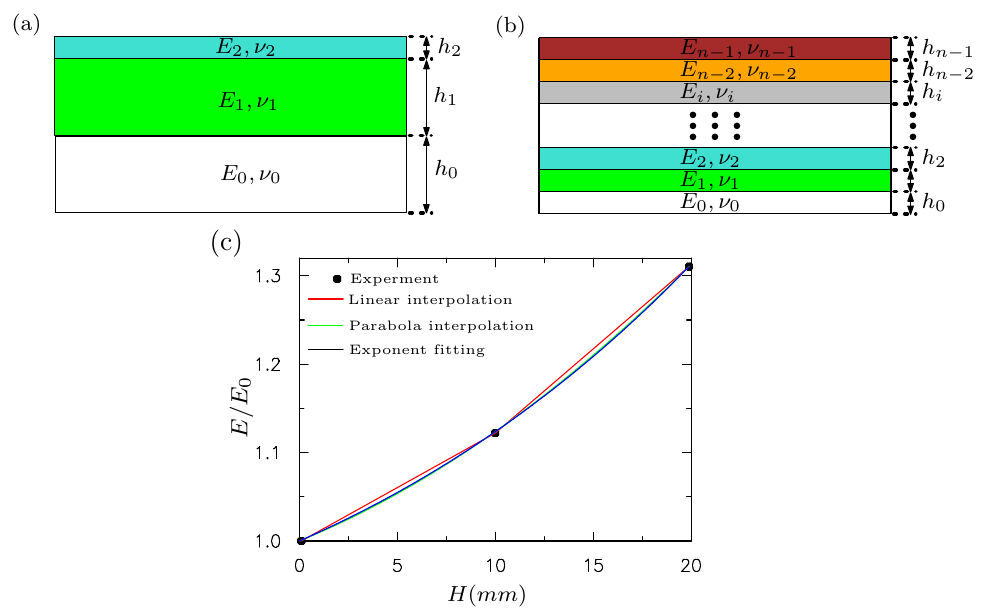
Figure 7. ( a ) schematic for the three-layer finite element model. The height for each layer is h 1 , h 2 , and h 3 with modulus E 0 , E 1 and E 2 , respectively; ( b ) schematic for a multi-layer finite element model with n = 200 layers. The height of the i th layer is h i with modulus E i . The height of each layer ( h i ) is equally distributed in the simulations; ( c ) the normalized modulus vs. height for the multilayer model based on linear interpolation, parabola interpolation and exponential fitting. The elastic modulus is normalized by E 0 .